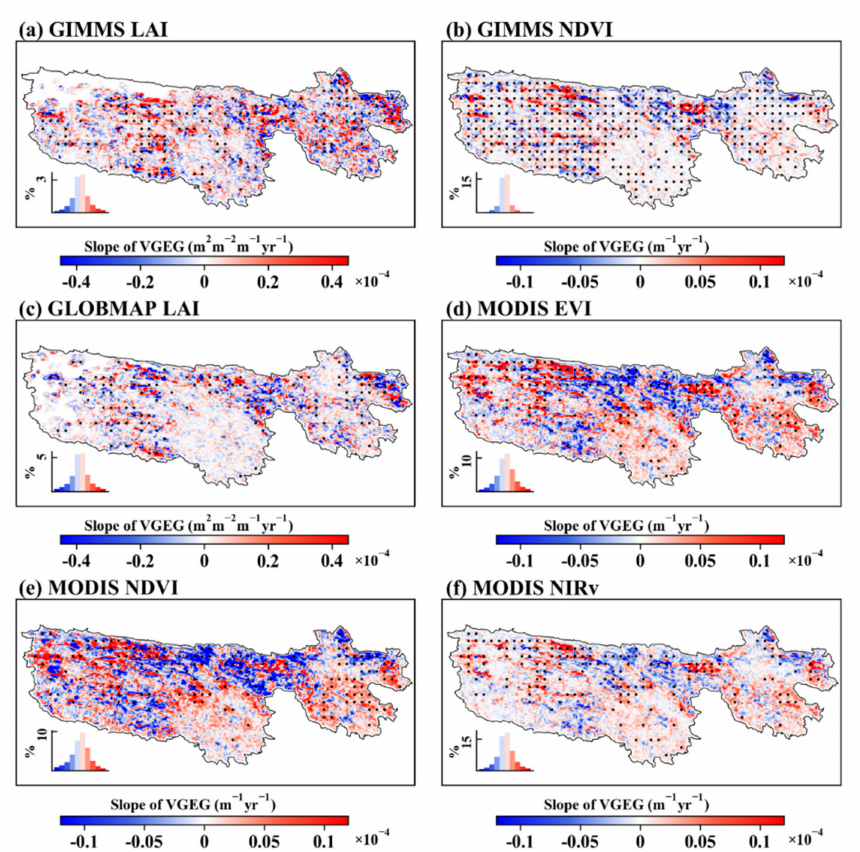
Figure 8. Spatial pattern of the VGEG (Vegetation Greenness along the Elevation Gradient) variation from 2001 to 2016. ( a ): Global Inventory Modeling and Mapping Studies leaf area index (GIMMS LAI); ( b ): GIMMS Normalized Difference Vegetation Index (NDVI); ( c ): Global Mapping (GLOBMAP) LAI; ( d ): Moderate Resolution Imaging Spectroradiometer Enhanced VI (MODIS EVI); ( e ): MODIS NDVI; ( f ): MODIS near-infrared reflectance of vegetation (NIRv). The value frequencies are shown in the bottom left inset for each panel. The regions with black dots (generated by 9 × 9 windows) indicate that the trend is statistically significant at the 0.05